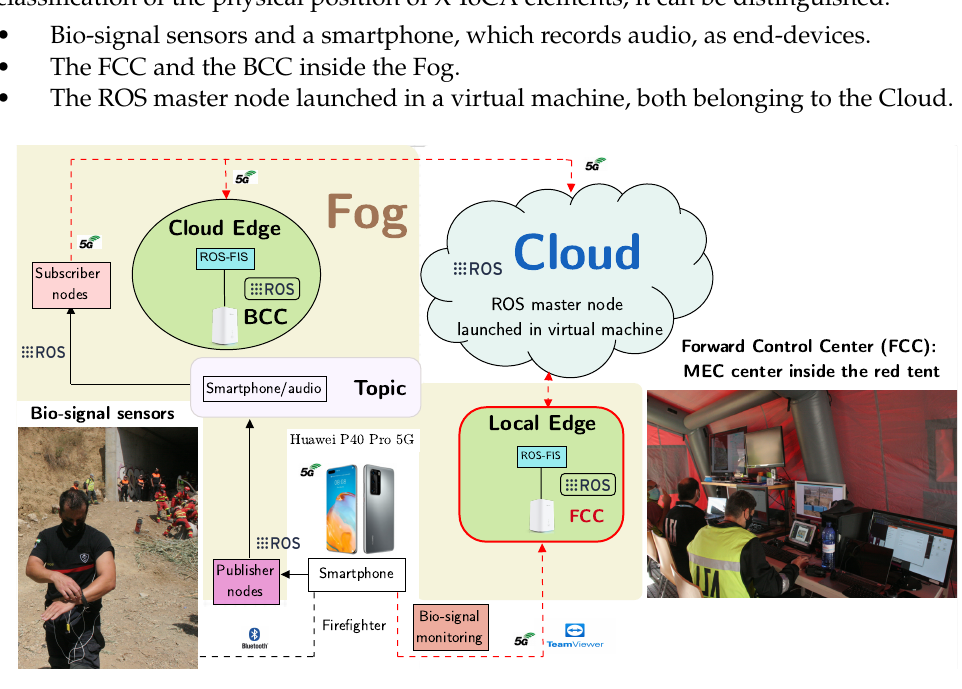
Figure 3. Part of the SAR-IoCA architecture for real-time bio-signal